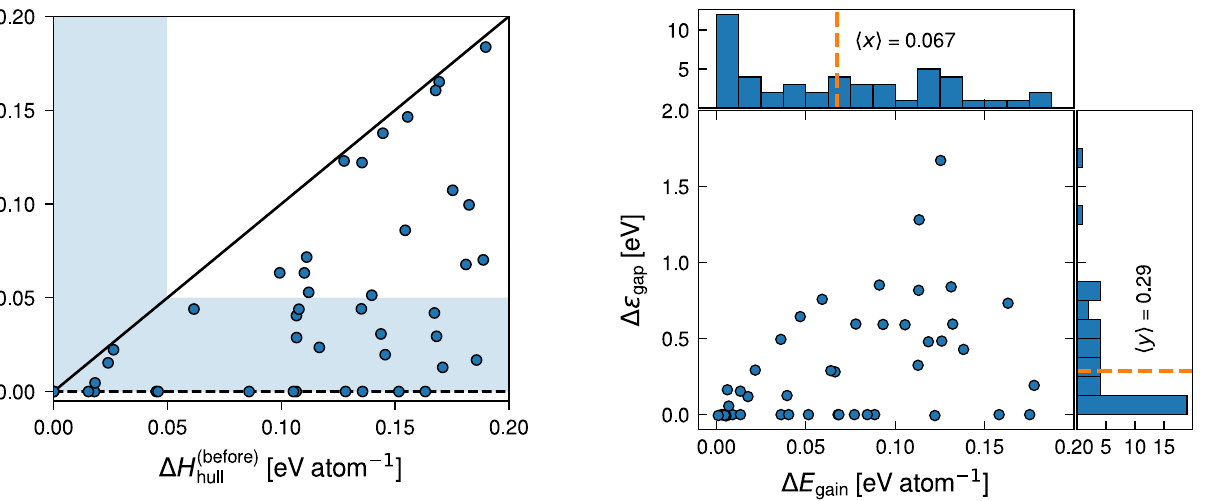
Fig. 6 The energy gain as a function of the gap opening for the stable materials. The average energy gain for the stable materials is 0.067 eVatom − 1 and the average gap opening is 0.29 hull